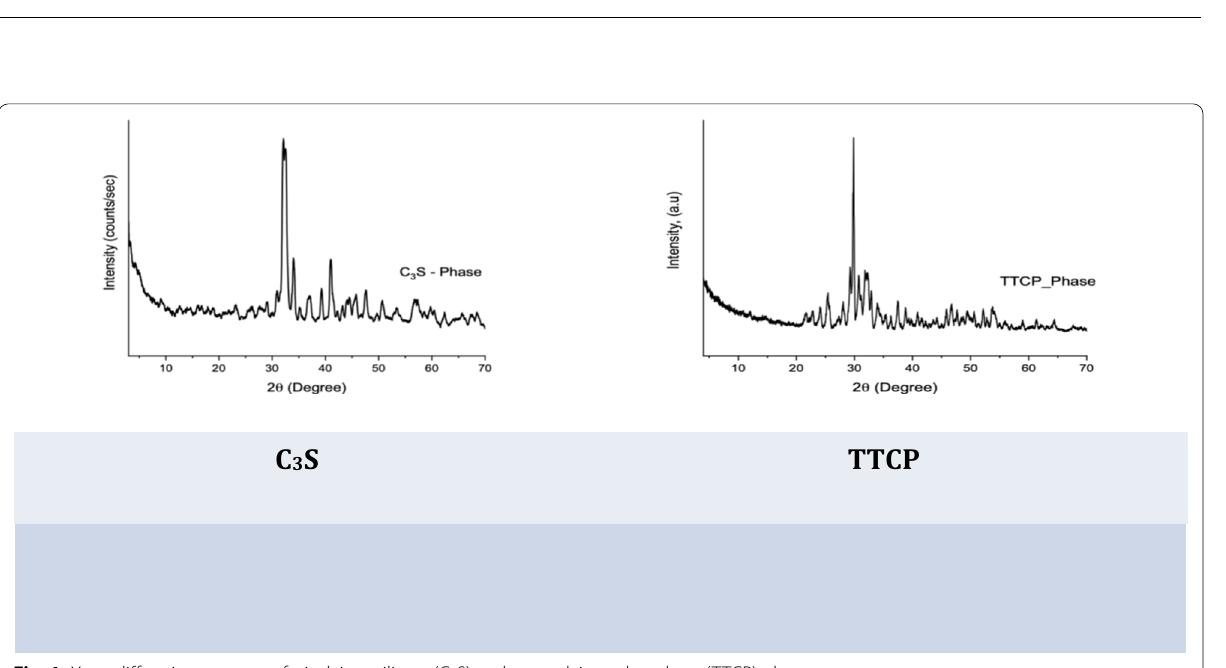
Fig. 1 X-ray diffraction patterns of tricalcium silicate (C 3 S) and tetracalcium phosphate (TTCP)